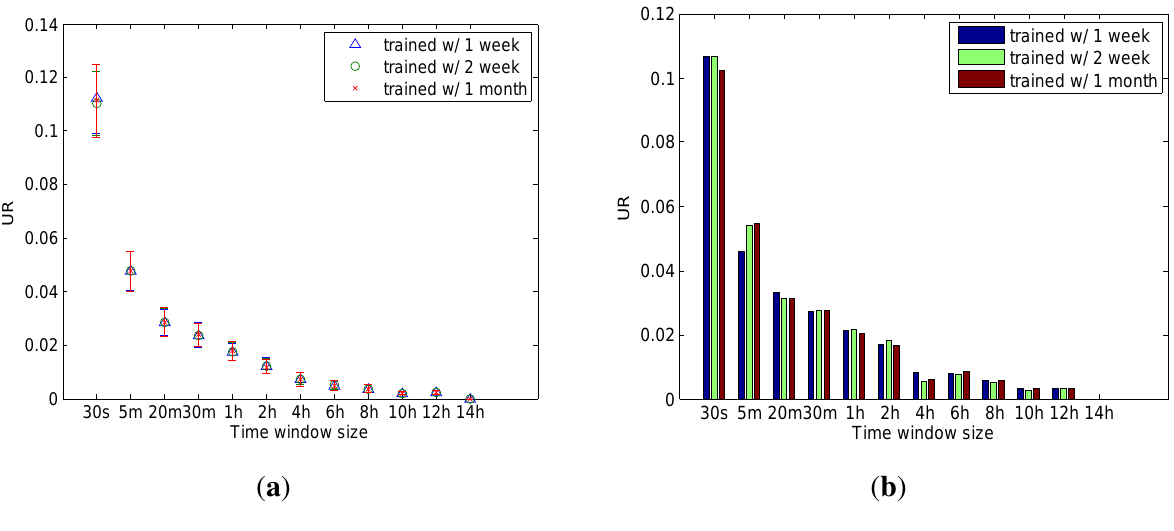
Figure 6. Activity cloak coverage: the unexpected event rate (UR) vs. the time window size. ( a ) 100 random days; ( b ) Day